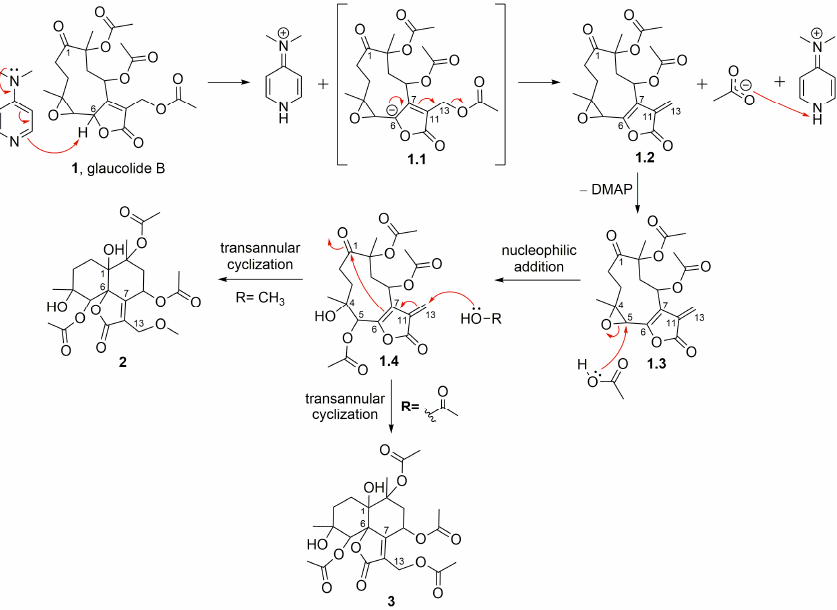
Figure 3. Proposed mechanism for the formation of semisynthetic derivatives 2 and 3 (red arrows illustrate the arrow-pushing mechanism).